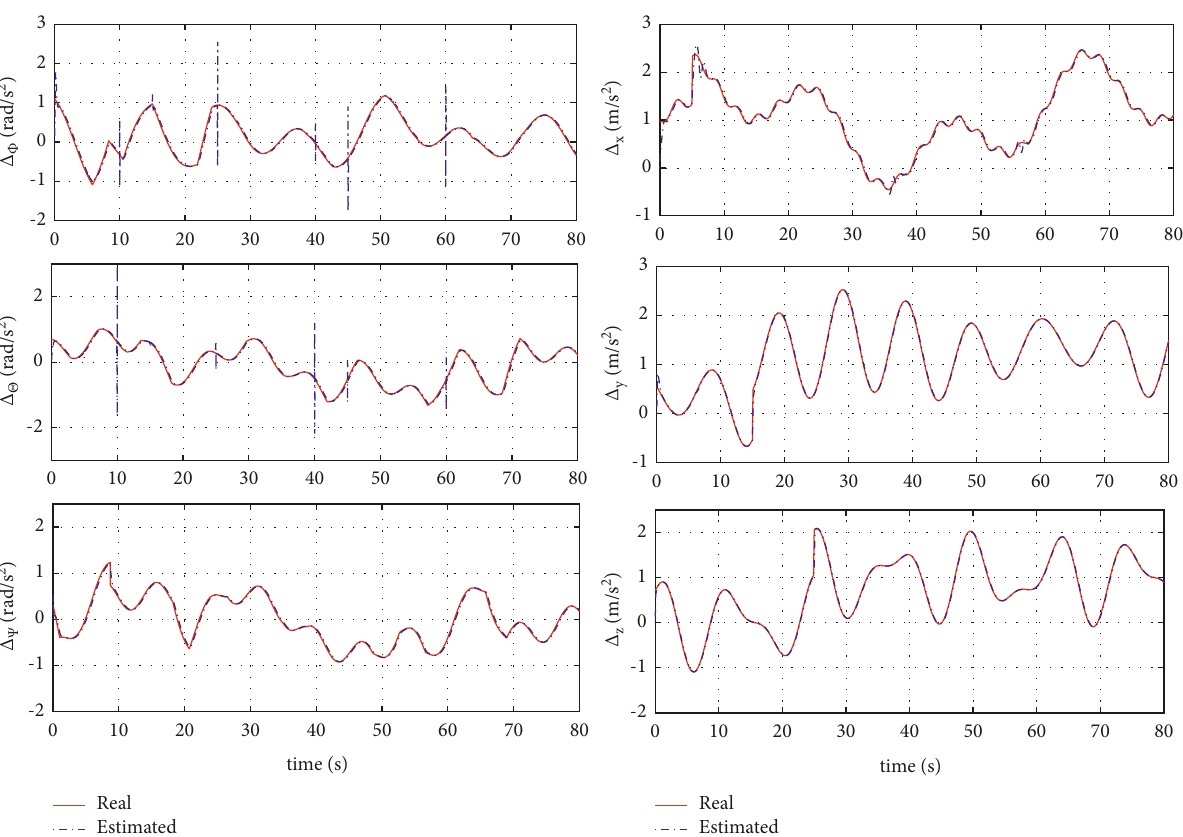
Figure 8: Estimation of external